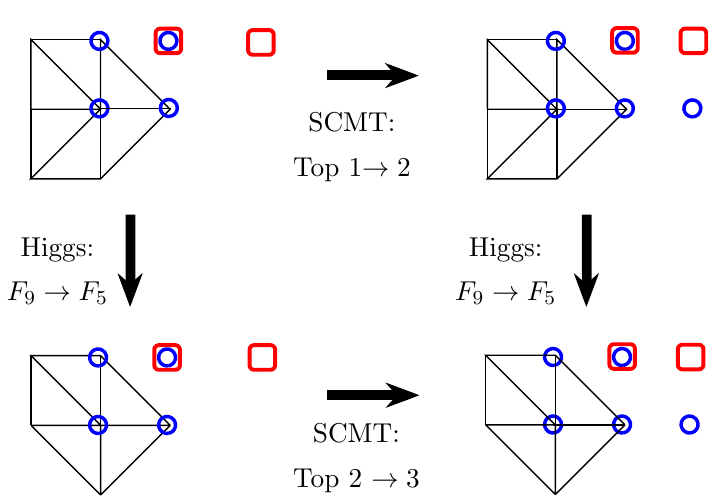
Figure 18 . Example for transitions between four di(cid:11)erent tops: superconformal matter transitions (SCMTs) add a point in a face of a top and yield a model with SCPs. Higgs transitions remove a vertex of the base polytope F 0 and reduce the rank of the additional gauge groups besides